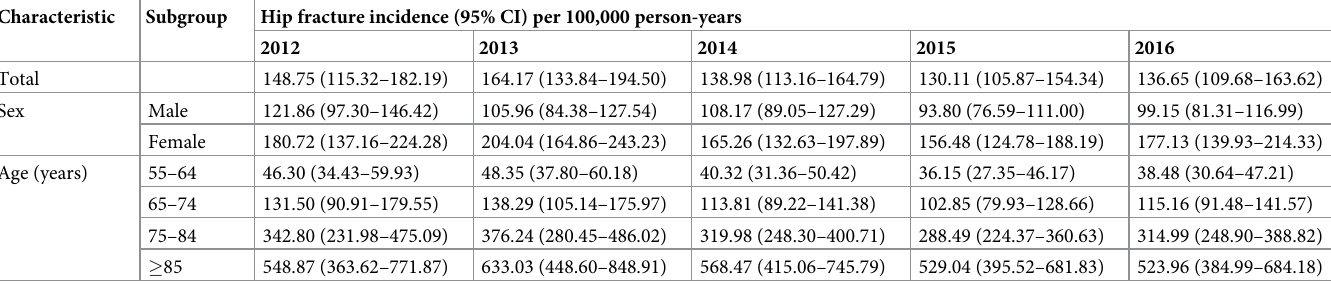
Table 2. Crude incidence of hip fracture grouped by sex and age group (per 100,000 person-years).